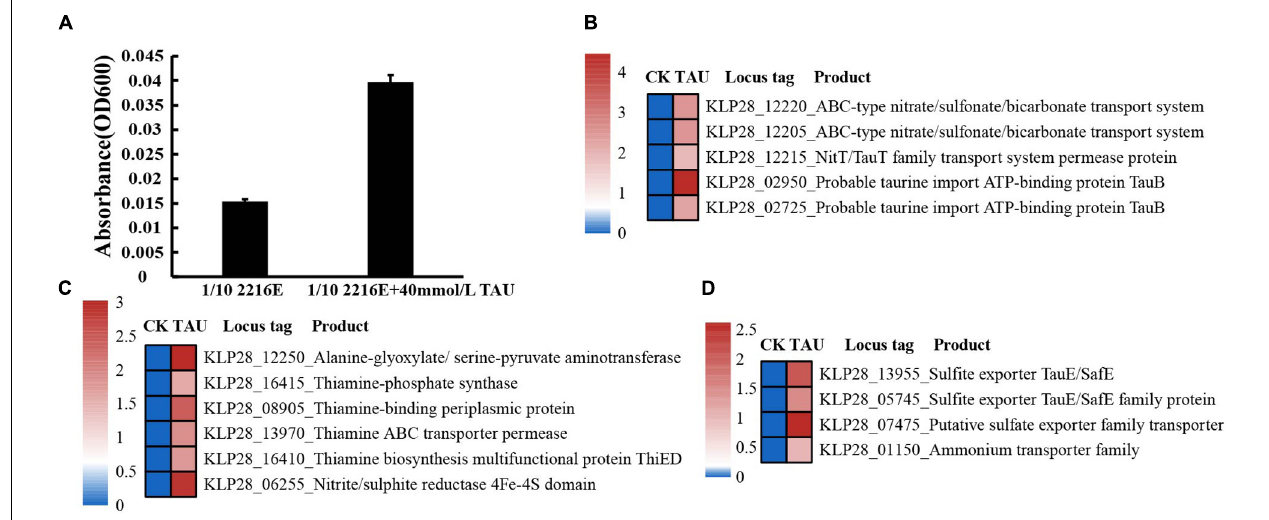
FIGURE 2 | Strain TYQ2 effectively utilizes taurine. (A) Growth assays of strain TYQ2 in the 1/10 2216E medium supplemented either without or with 40 mM taurine. (B) A heat map based on transcriptomics analysis showing the up-regulated genes associated with taurine and sulfonate transport. (C) A heat map based on transcriptomics analysis showing the up-regulated genes associated with the metabolism of taurine. (D) A heat map based on transcriptomics showing the up-regulated genes involved in metabolites